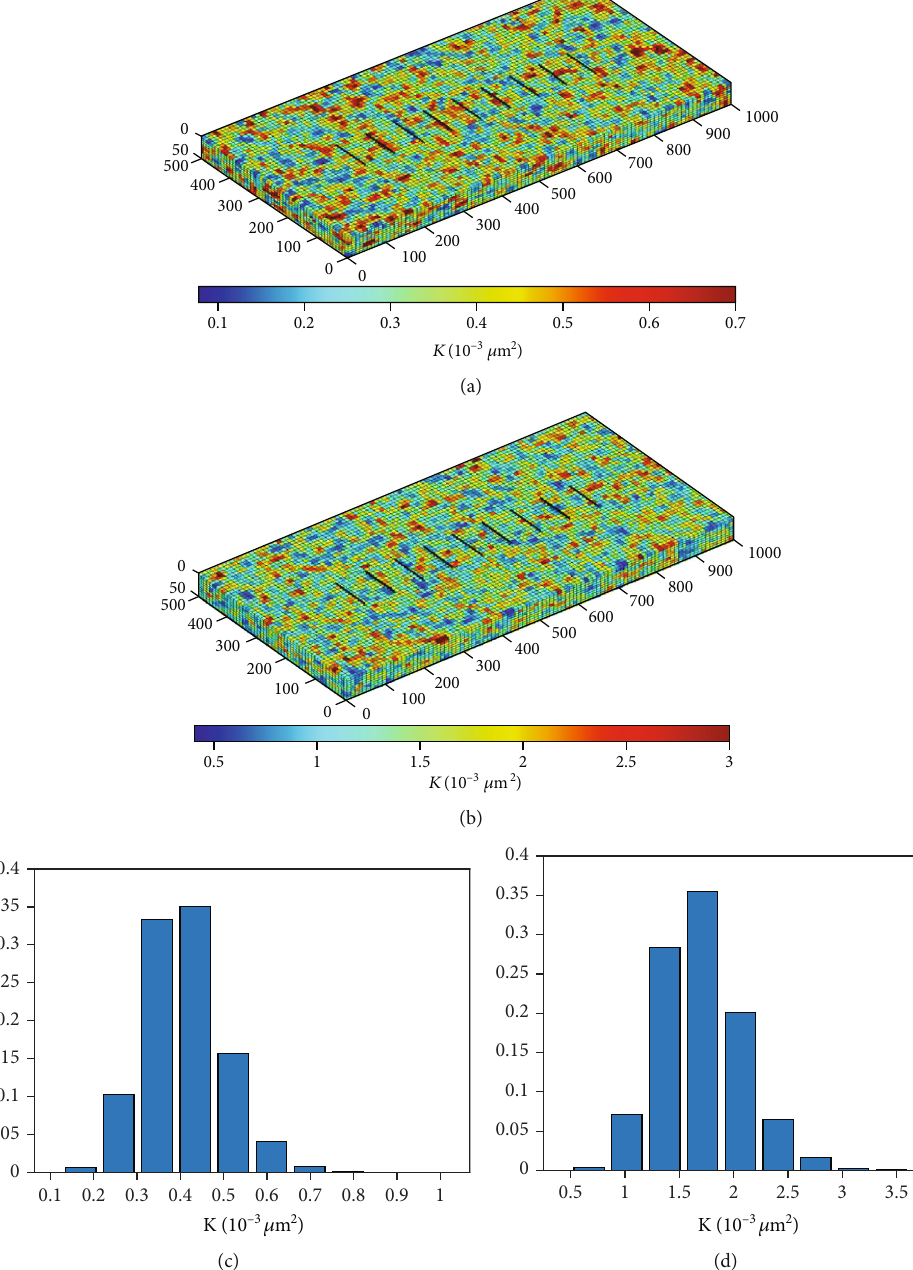
Figure 7: Permeability and its probability distribution: (a) and (b) are the permeability distribution of set 1 and set 3; (c) and (d) are the probability histogram of permeability distribution of set 1 and set